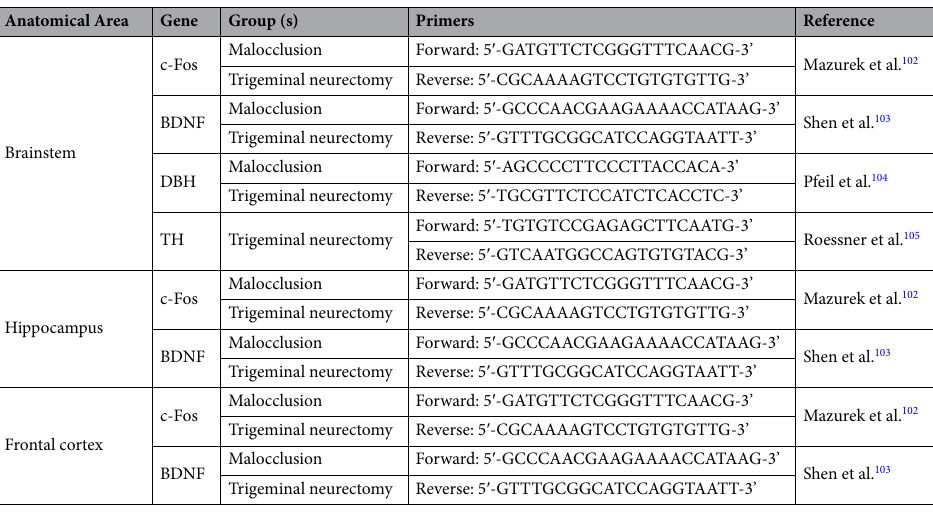
Table 5. Inferior alveolar nerve resection: primers used in gene expression analysis. Target genes: c-Fos, brain- derived neurotrophic factor (BDNF), dopamine beta-hydroxylase (DBH), tyrosine hydroxylase